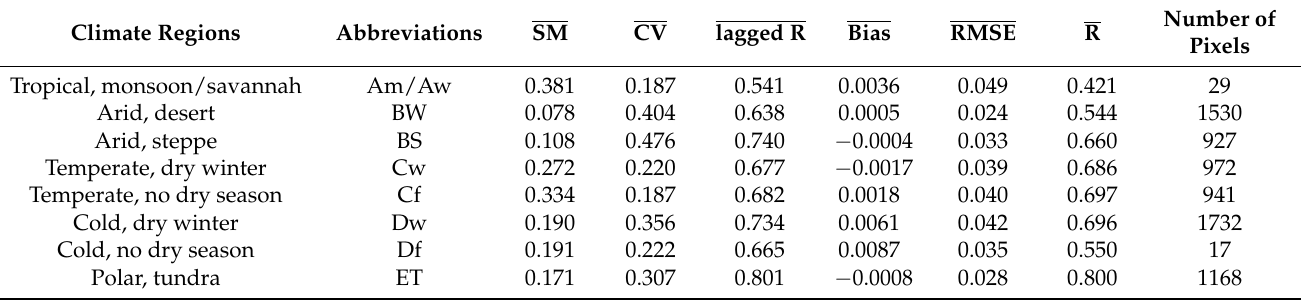
Table 1. Mean value of different metric of different climate regions, including soil moisture (SM, m 3 /m 3 ), Coefficient of Variation (CV) and the lagged correlation of SM (lagged R), the Bias (m 3 /m 3 ), root-mean-square error (RMSE, m 3 /m 3 ) and Pearson’s Correlation Coefficient (R) of the DI_ConvGRU, and number of